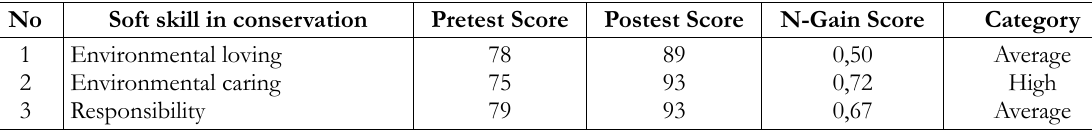
Table 3. N-Gain Score of Conservation Characters of